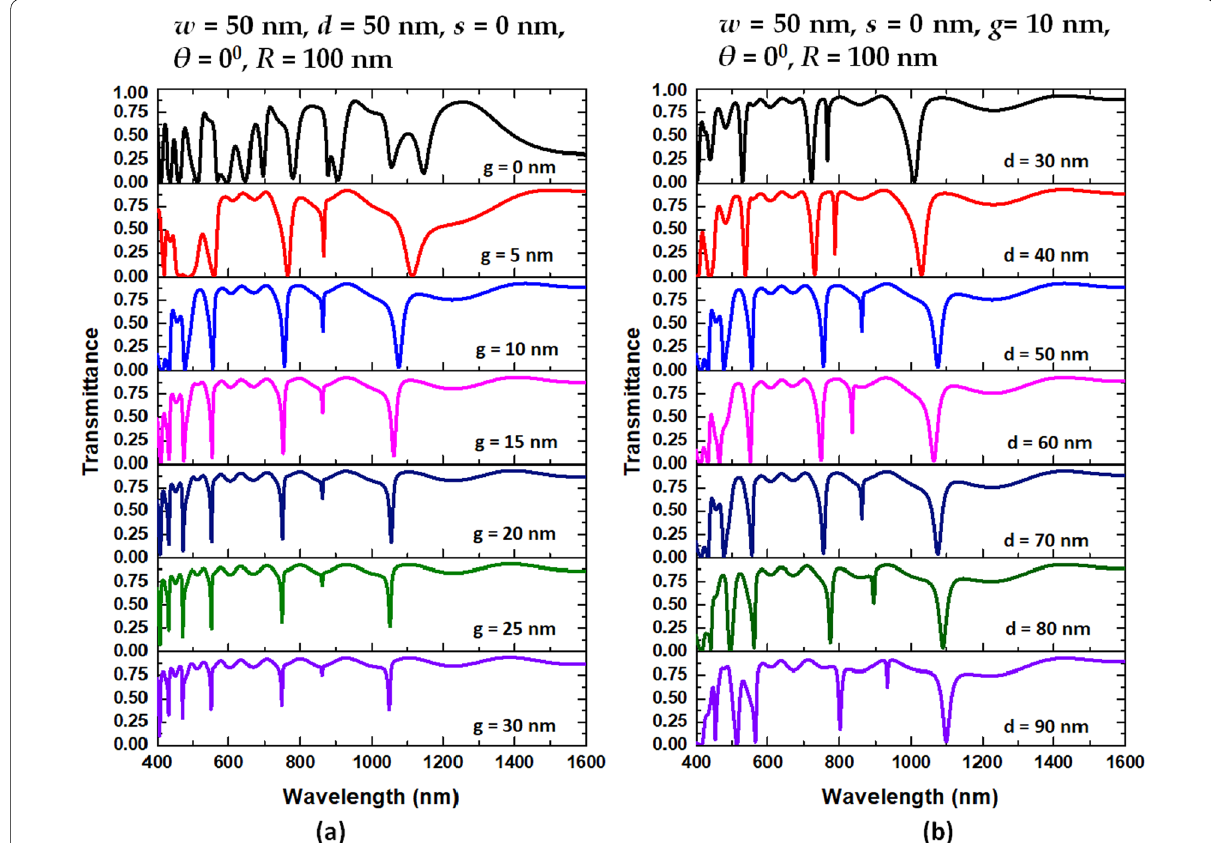
Fig. 4 Transmittance spectra of the case 3 structure with a variation of g and b variation of d ,